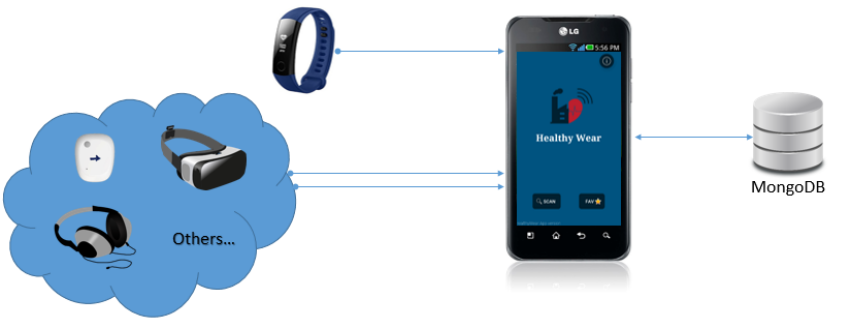
Figure 5. Overview of the applied wearable data flow.